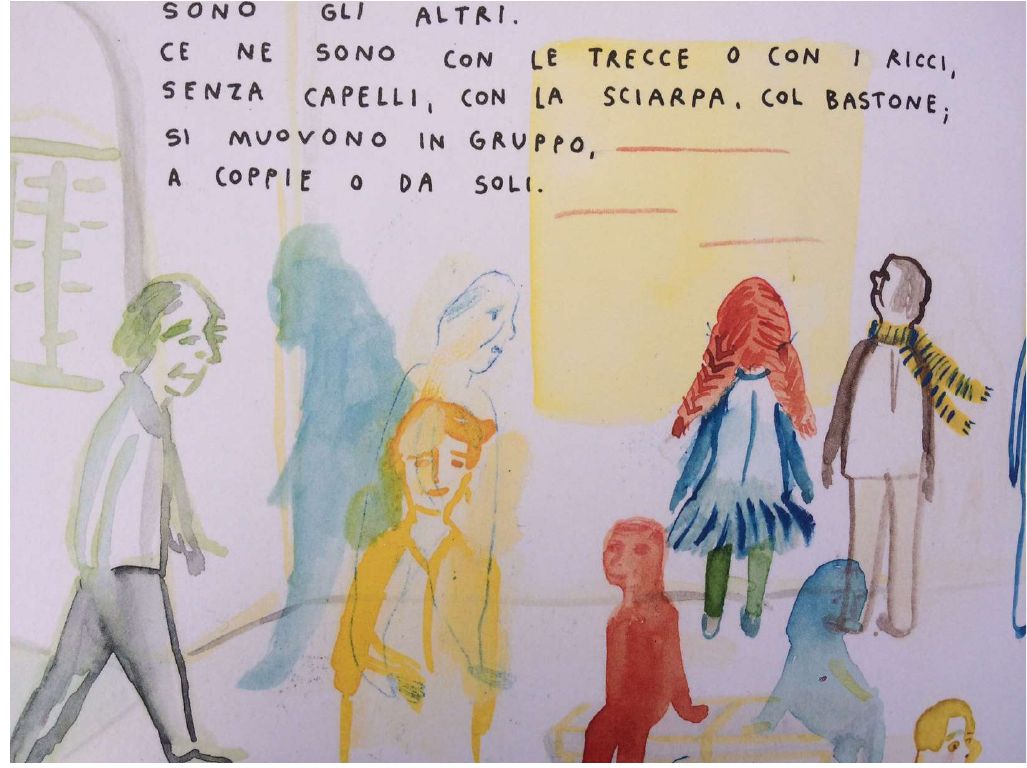
Figura 3. Image of the streets, by: Gli altri , cit. p. 4.